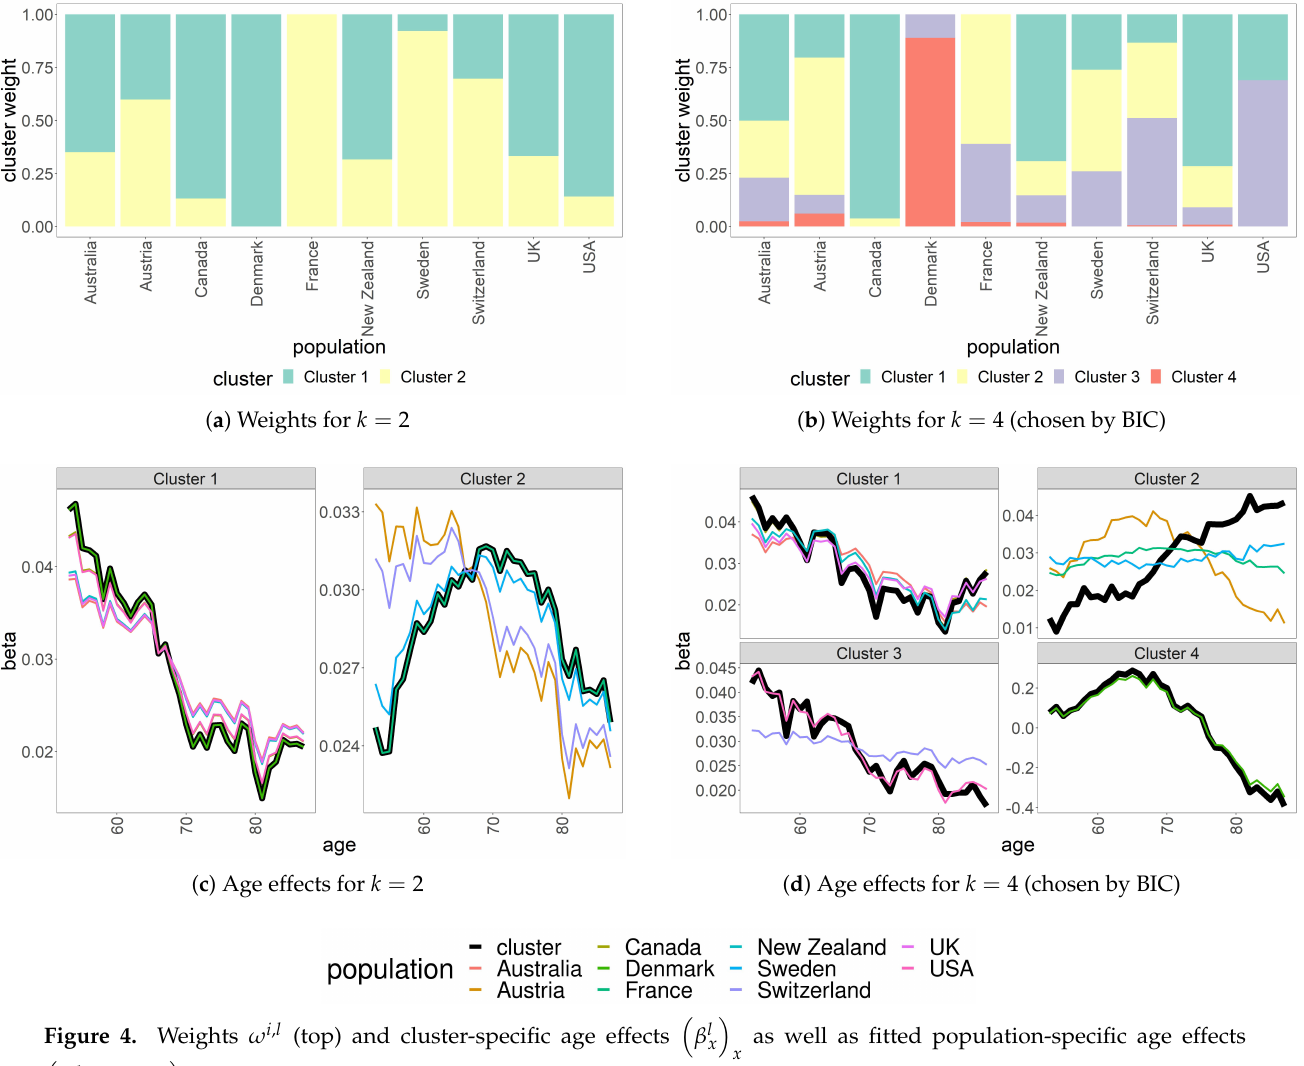
Figure 4. Weights ω i , l (top) and cluster-specific age effects (cid:16) (cid:17) ∑ k ω i , l β l x (bottom) of the fuzzy maximum likelihood clustering for males aged 53 to 87 in 10 countries between l = 1 x 1948 and